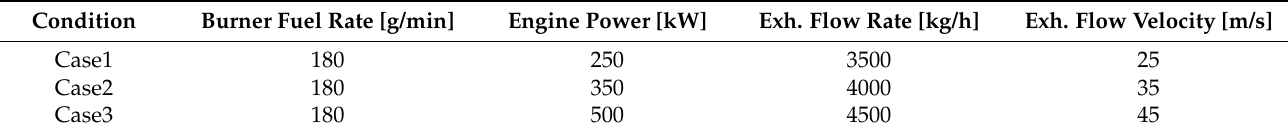
Table 4. Experimental conditions for ignition.